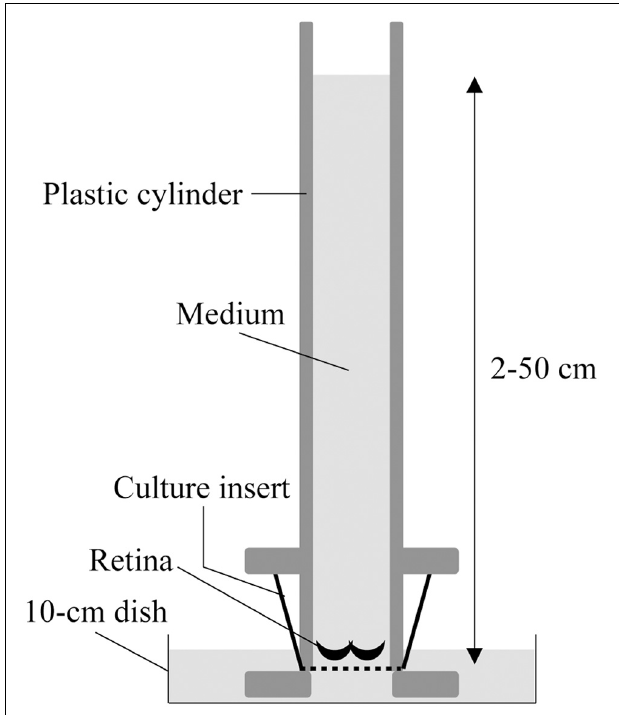
FIGURE 1 | Schematic illustration of the two-chamber culture system for pressure loading. The retinae were submerged in media and placed at the bottom of a culture insert with Matrigel. The culture insert was connected to the bottom of a 50-cm-long plastic cylinder that enabled 2–50 cm H 2 O pressure loading, and was placed in a 10-cm culture dish where the culture insert made contact with the medium under free gas exchange